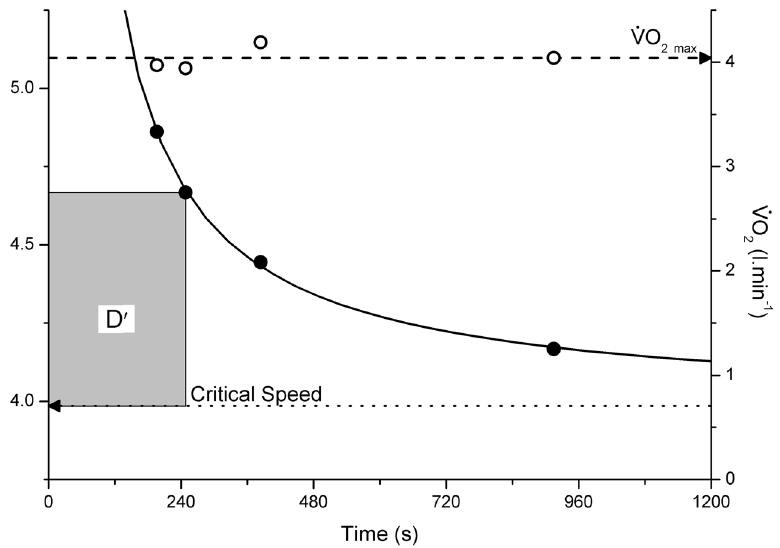
N Figure 2. The relationship between speed and tolerable duration for 4 constant-speed tests (continued to exercise intolerance) in a ). A hyperbolic relationship has been fitted to these data (solid line) allowing estimation of critical speed and D 9 . Also representative subject ( plotted is the _ VVO 2 for each of these constant-speed tests ( # ), demonstrating _ VVO 2 max was attained in each test.